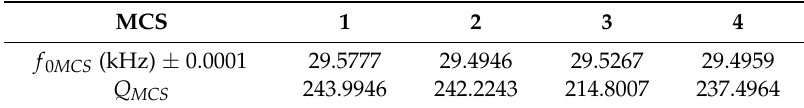
Table 1. The measured resonance frequency f 0 of each micromechanical cantilever sensor (MCS) at the reference temperature of T 0 = 298 K together with their corresponding quality factors, Q MCS